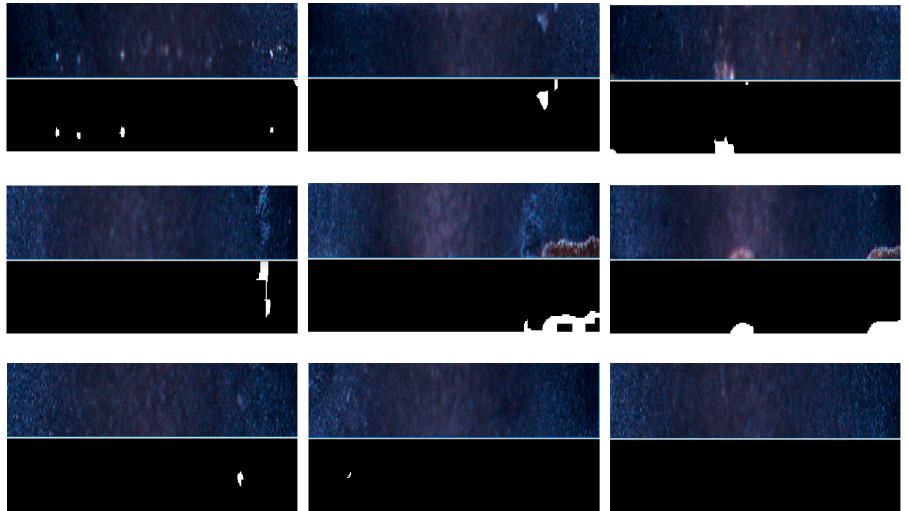
Figure 8. A total of nine images are shown. Each image is composed of two parts: the original image of resistance on the top and the edge detection image of resistance on the bottom. We will determine whether the resistance is damaged according to the white area in the edge detection diagram.